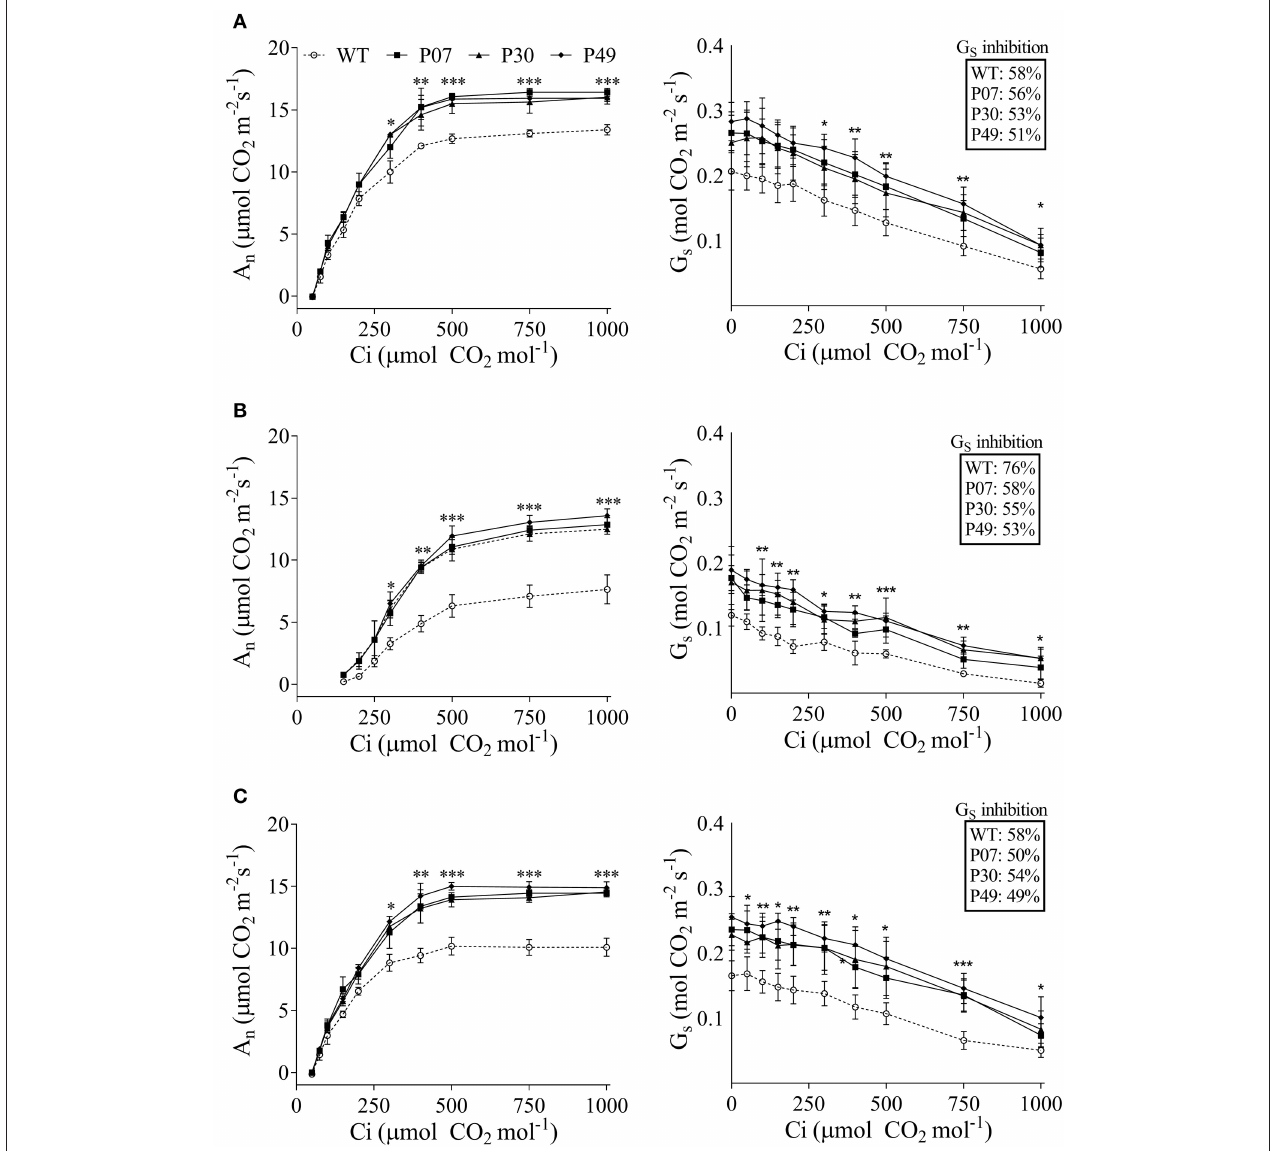
FIGURE 4 | The impact of water limitation on net carbon assimilation and stomatal conductance response to CO 2 in WT (dashed line) and transgenic plants (plain lines). The measurements were taken using the first expanded leaf during the whole course of the experiment in (A) control, (B) drought-stressed, and (C) recovery plants at growth light intensity. Measurements of the drought-stressed plants were taken at the end of the stress period, whereas recovery measurements were taken after 3 days of recovery under normal irrigation. Points represent the means of 5 plants ± SD. Points with *, **, and *** mean that all three transgenic lines differ significantly from the WT ( P < 0.1, P < 0.05, and P < 0.01,